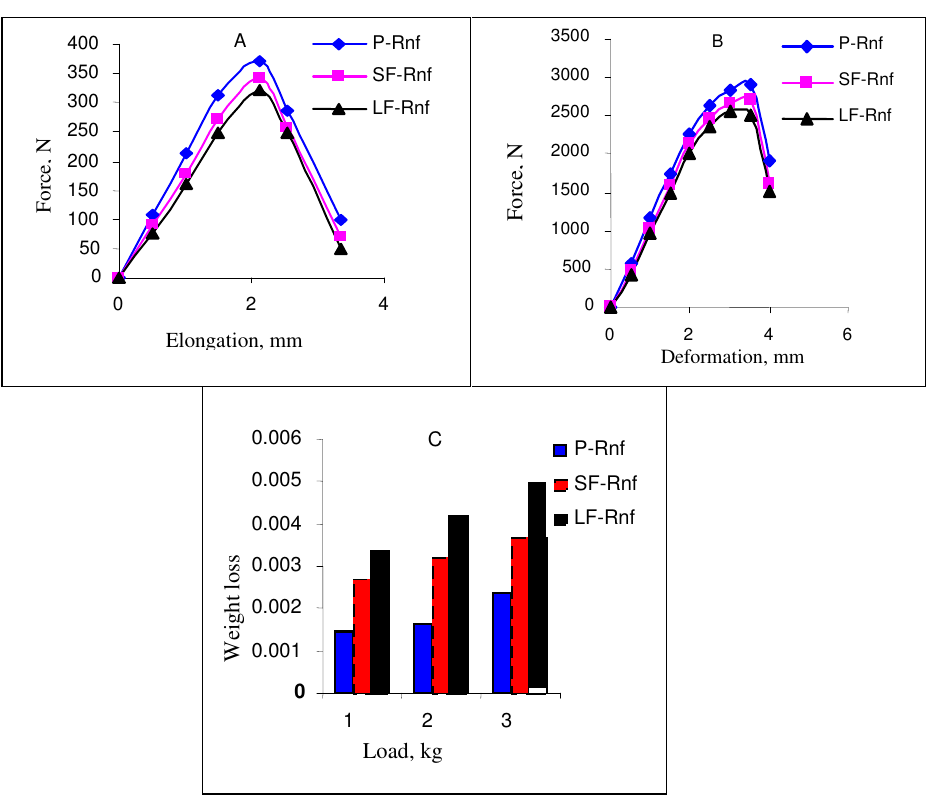
Figure 1. Tensile/compressive and wear resistance curves (A-C) of Grewia optiva fiber reinforced polymer composites.